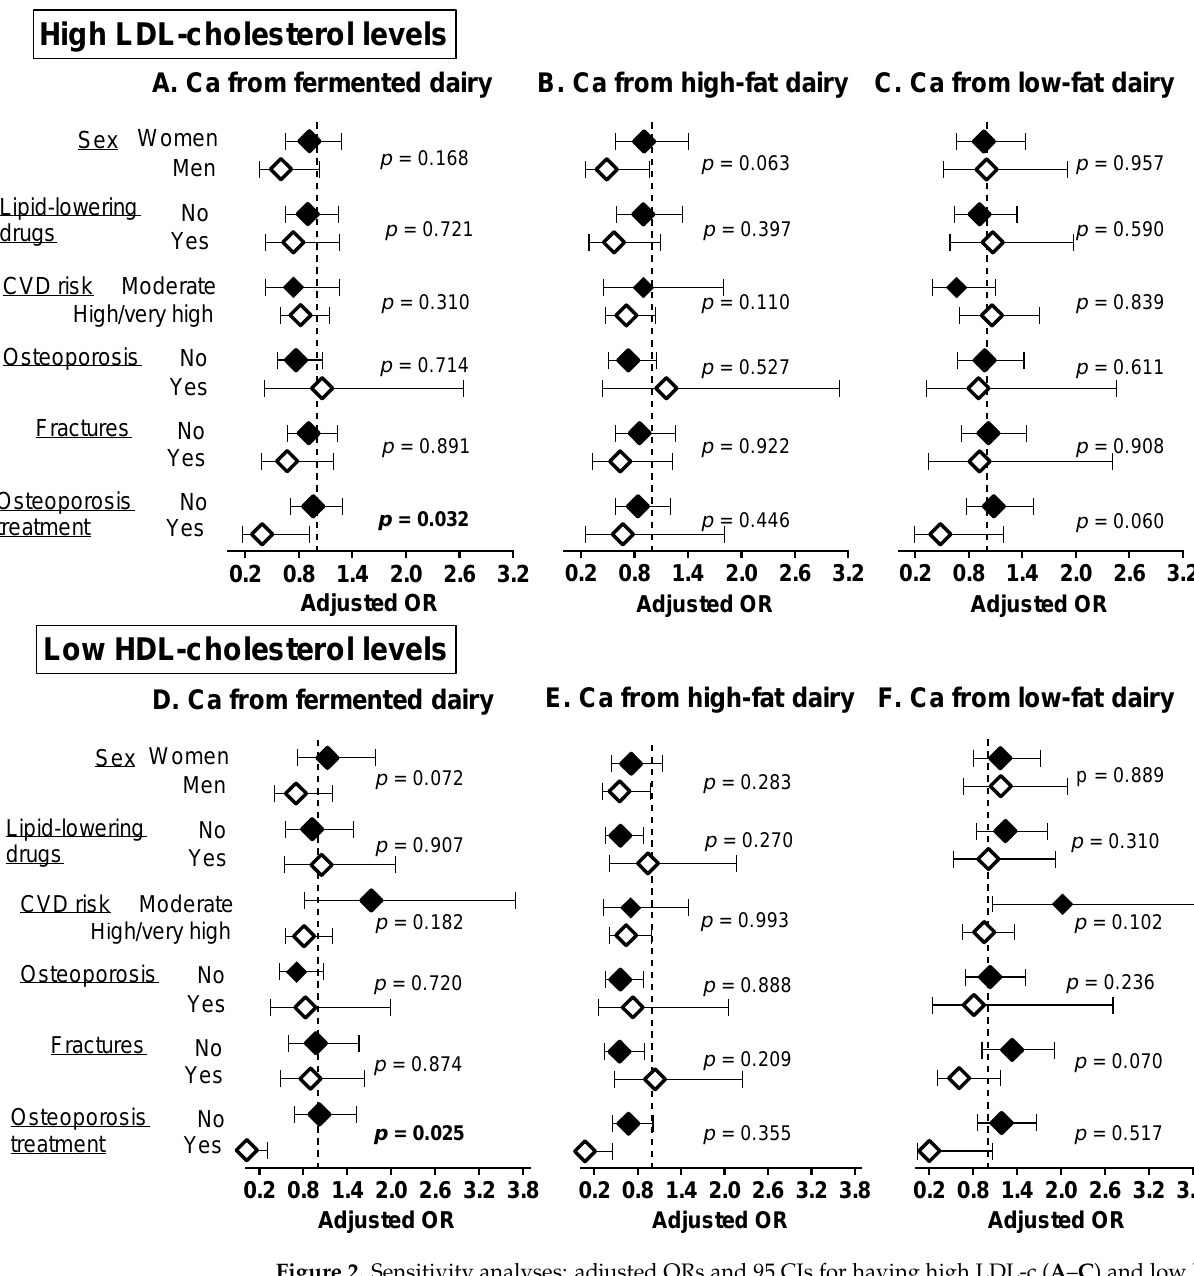
Figure 2. Sensitivity analyses: adjusted ORs and 95 CIs for having high LDL-c ( A – C ) and low HDL-c ( D – F ) levels per 300 mg increase in calcium intake from fermented, high and low-fat dairy products. Models were adjusted for age, sex, weight, height, smoking status, alcohol intake, dietary energy intake, physical activity energy expenditure and use of medication (statins or other lipid-lowering drugs, antihypertensive drugs, antidiabetic drugs) Results are expressed per 300 mg increase in Ca intake (quantity provided by one serving of dairy products). p -values refer to the interaction of each calcium from fermented/high-/low-fat dairy products and the stratifying variable. Significant p -values (<0.05) are indicated in bold. Ca: calcium, CVD: cardiovascular disease, HDL-c: high- density lipoprotein cholesterol, LDL-c: low-density lipoprotein cholesterol.